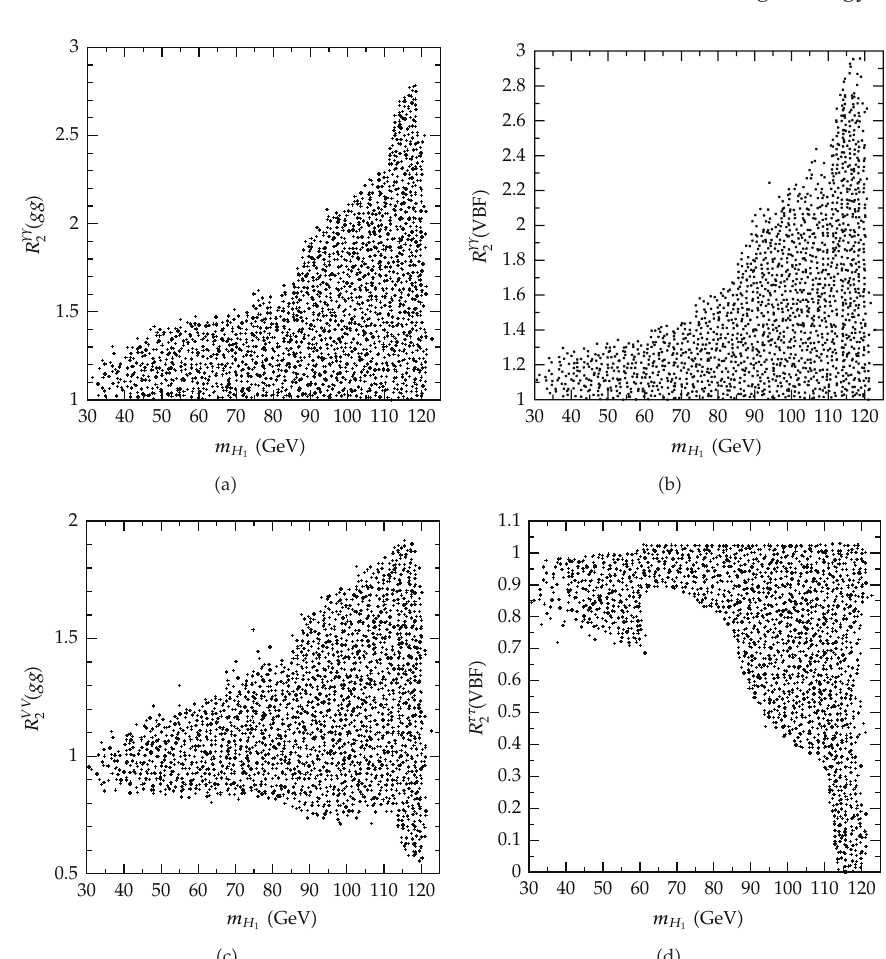
Figure 1: Reduced signal cross sections R 2 for H 2 with a mass in the 124–127GeV range, as a function of for a representative sample of viable points in parameter space. (cid:2) a (cid:3) R γγ M H 1 production via gluon fusion (cid:3) , (cid:2) b (cid:3) R γγ WW channels, H 2 production via gluon fusion (cid:3) , and (cid:2) d (cid:3) R ττ